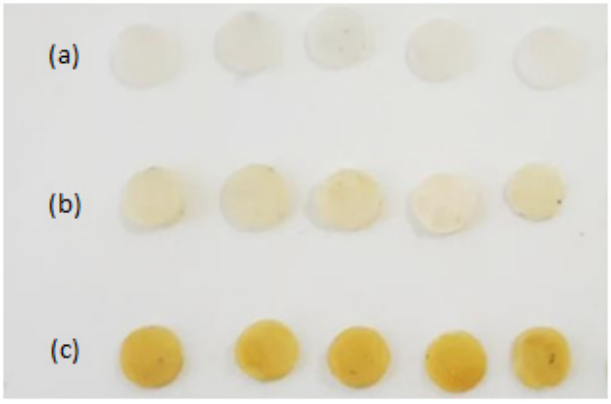
Figure 2. Adhesive materials ready to be tested. Resin-modified glass ionomer cement ( a ) control, ( b ) 15% propolis, and ( c ) 25%